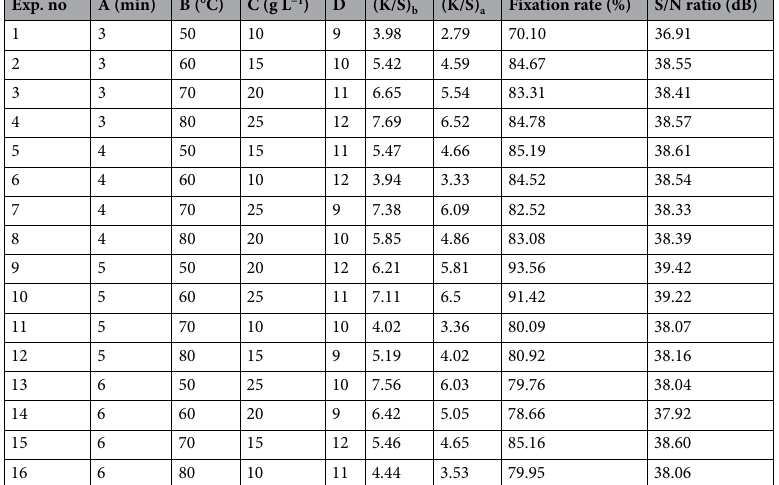
Table 3. Details results of L 16 orthogonal design.